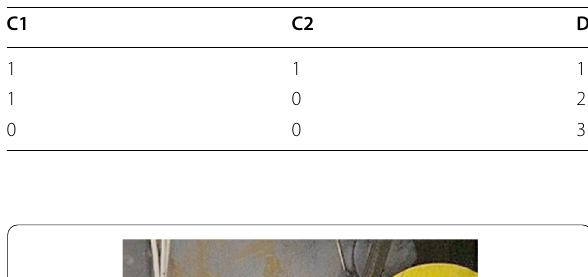
Table 2 Decision rule table for the simulation experiment